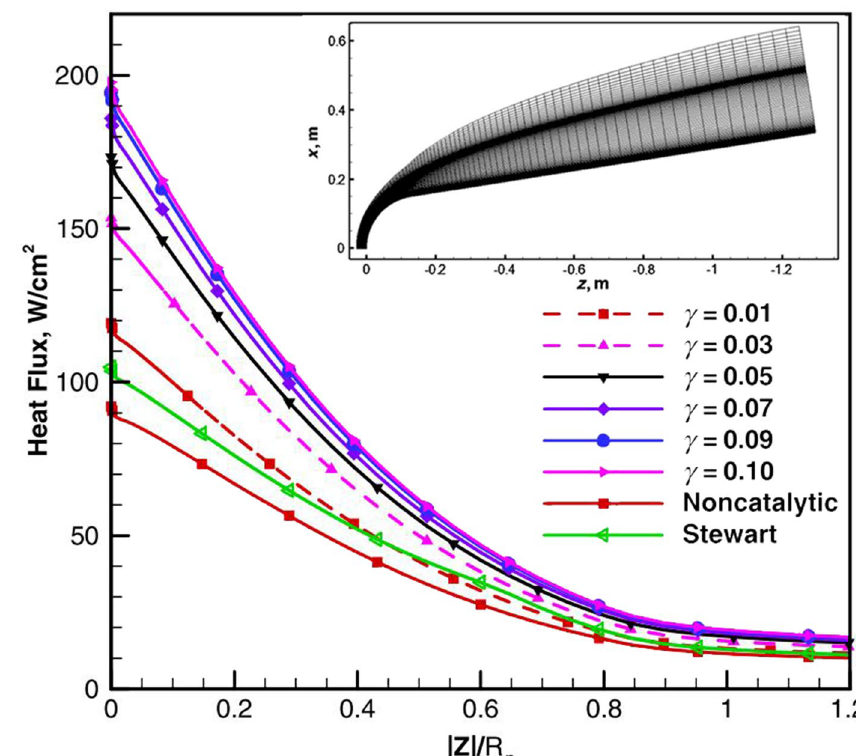
Fig. 15 Heat flux for RAM-C II